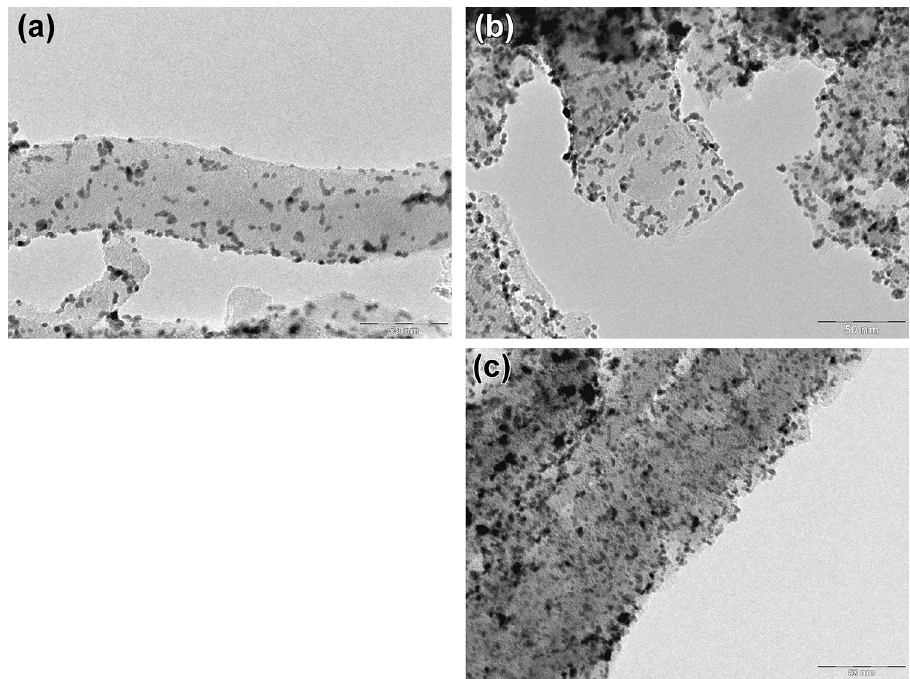
Fig. 4 TEM images of the Pt/ MCs. a Pt(7.2 wt%)Ni100MC, b Pt(6.9 wt%)Ni80Cu20MC, and c Pt(14.8